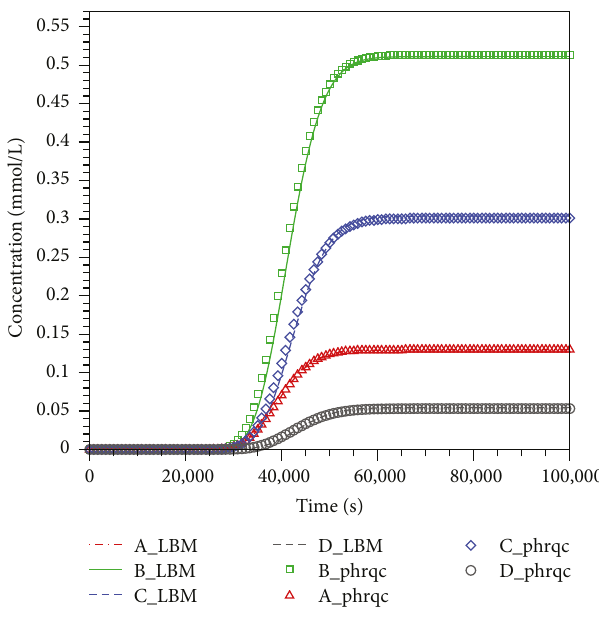
Figure 33: Breakthrough curves for four di ff erent species at the outlet of a domain where species A is injected into the domain and a chain of decay reactions occurs between four species. Di ff erent lines show the results obtained with the LBM approach, and symbols indicate the results simulated using